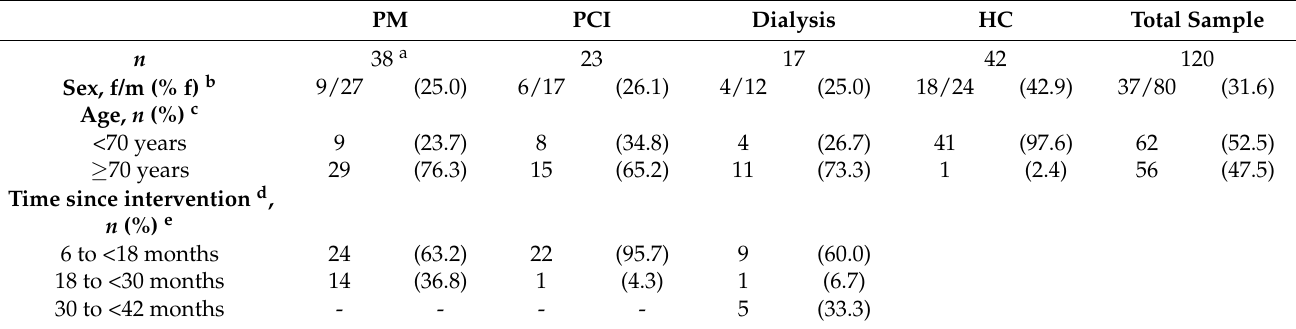
Figure 1. Gender and age distribution ( n = 120 in total study sample). Panel ( A ) illustrates the gender distribution. Panel ( B ) illustrates the age distribution. Abbreviations: Dialysis: Dialysis control group. HC: Healthy control group. PCI: Percutaneous coronary intervention (PCI) control group. PM: Pacemaker (PM) group. Table 1. Sociodemographic characteristics of the study sample.